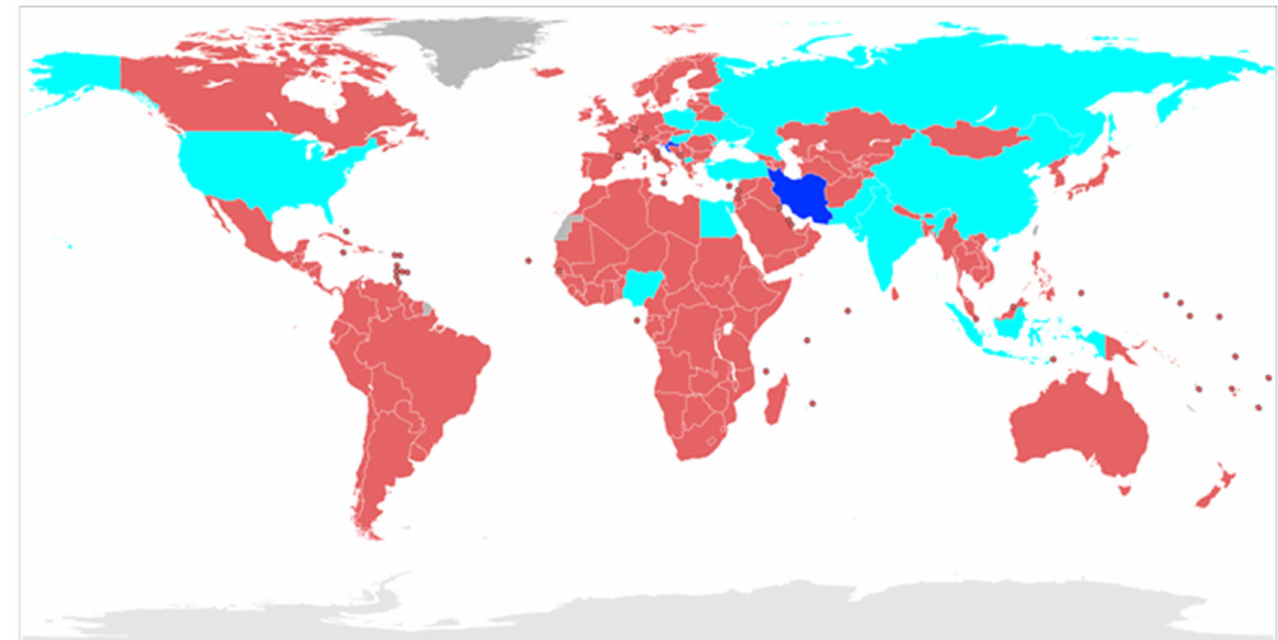
Figure 3. The countries where the submitted published papers in the period October 2020–October 2021 came from. The dark blue countries are those with more than 10 papers, the light blue countries are those with 10 or less papers (the red countries are not listed in the author’s addresses for the analysed